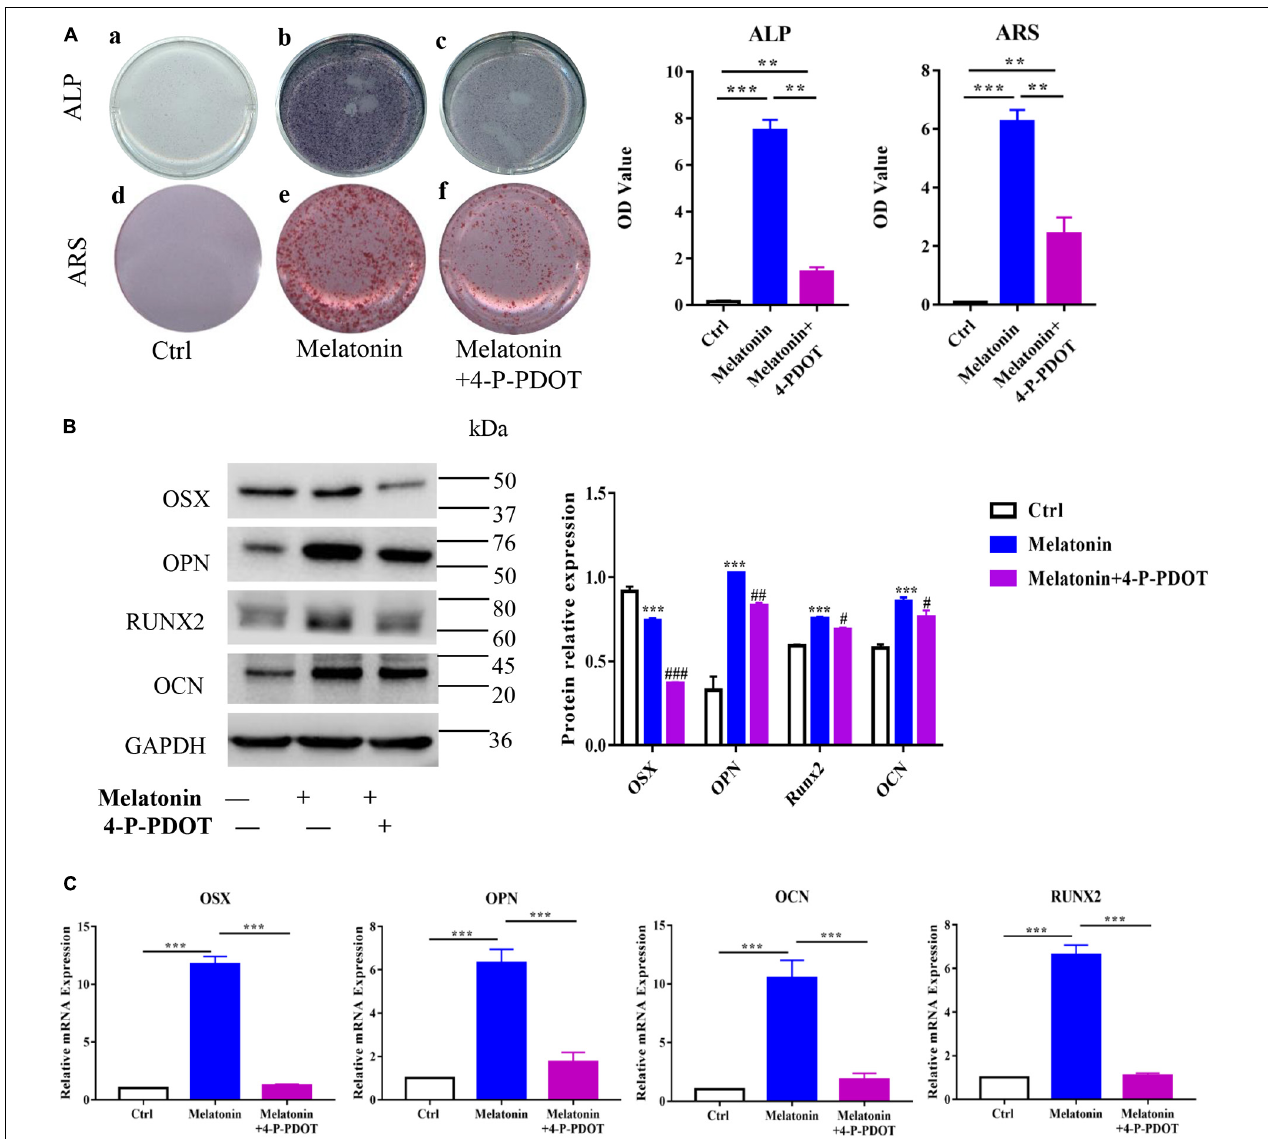
FIGURE 8 | Inhibition of the melatonin-MT2 pathway suppressed the osteogenesis of EndMT-induced RAOECs. (A) The rescue effect of 4-P-PDOT on melatonin-induced osteogenesis was observed by ALP and Alizarin Red staining. (B,C) Western blot with protein quantification and quantitative RT-PCR showed that 4-P-PDOT reversed the melatonin-induced expression of osteogenic differentiation markers. The data represent the mean ± SD. ** P < 0.01, *** P < 0.001 versus the control group and melatonin group. # P < 0.05, ## P < 0.01, and ### P < 0.001 versus the melatonin